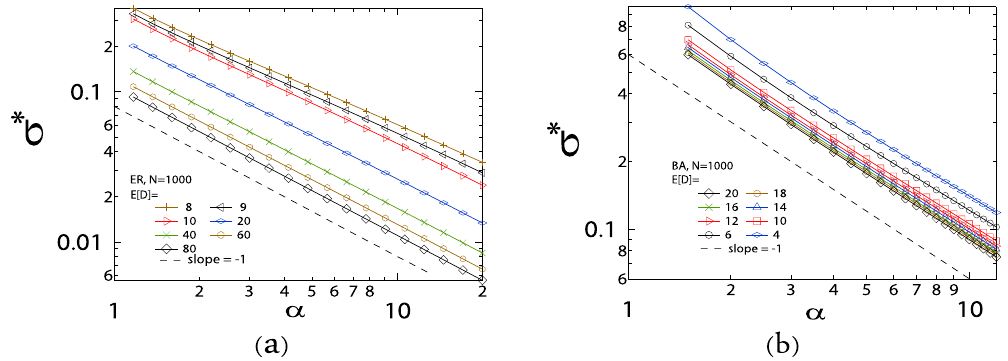
Figure 5. The normalized standard deviation σ * of infection probabilities of all nodes as a function of α in ( a ) ER and ( b ) BA random graphs. The dash line is a power-law curve with the exponent γ = − 1. The sizes of all random graphs are 1000 and the average degree E [ D ] is shown in the figures. The meta-stable infection probability v k ∞ ( α ) is obtained by solving (11) and the value of σ * ( α ) is obtained by (7). The NIMFA epidemic (1) τ ≈ . , 0.0993, 0.0902, 0.0476, 0.0244, 0.0164 and 0.0124 for ER random graphs with the threshold 0 1097 c (1) τ ≈ . , 0.0698, 0.0479, 0.0416, 0.0368, average degree E [ D ] = 8, 9, 10, 20, 40, 60 and 80 respectively, and 0 0902 c 0.0329, 0.0300 and 0.0274 for BA random graphs with the average degree E [ D ] = 4, 6, 10, 12, 15, 16, 18 and 20 respectively. The results are averaged over 10 realizations.